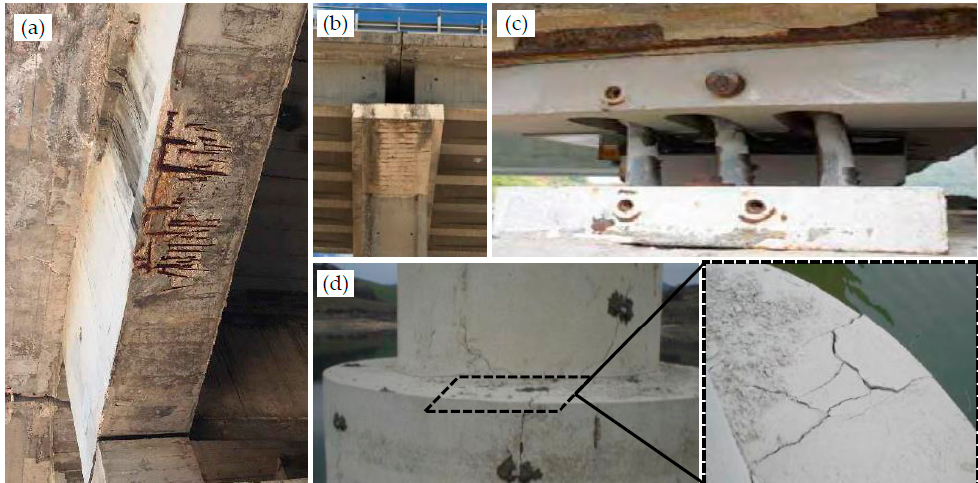
Figure 3. State of conservation of both bridges before retrofitting works: ( a ) damage in a lateral beam and ( b ) on the piers of the B1 bridge, ( c ) plastic deformation of support studs and ( d ) crack pattern along the body of one pier for the B2 bridge.